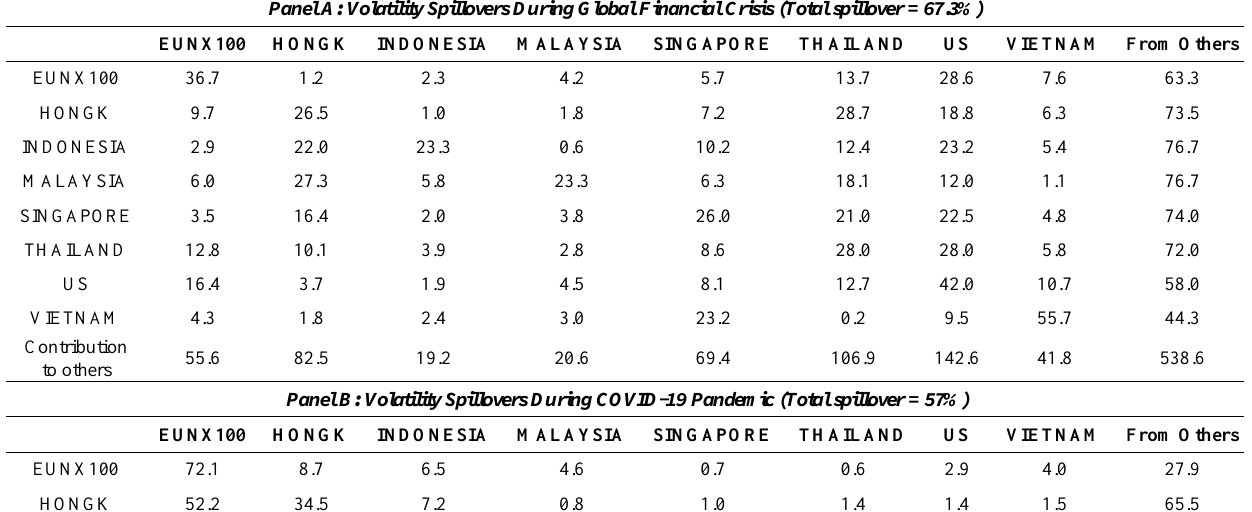
Table 3. Diebold and Yilmaz Test Results for Volatility Spillovers during the Three